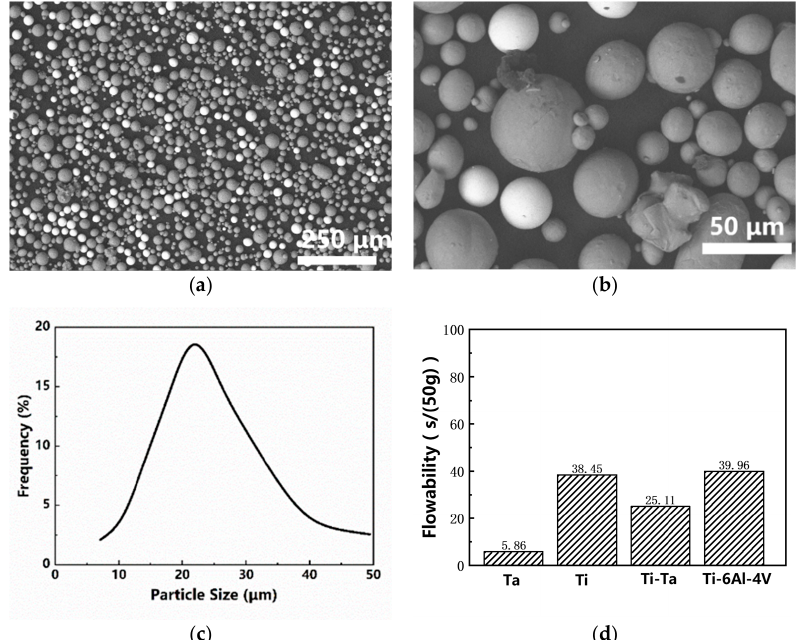
Figure 2. The BSE images of ( a , b ) mixed Ti ‐ Ta powder, ( c ) particle size distribution of mixed Ti ‐ Ta powders and ( d ) fluidity of original pure Ti, original pure Ta and mixed Ti ‐ Ta powders.